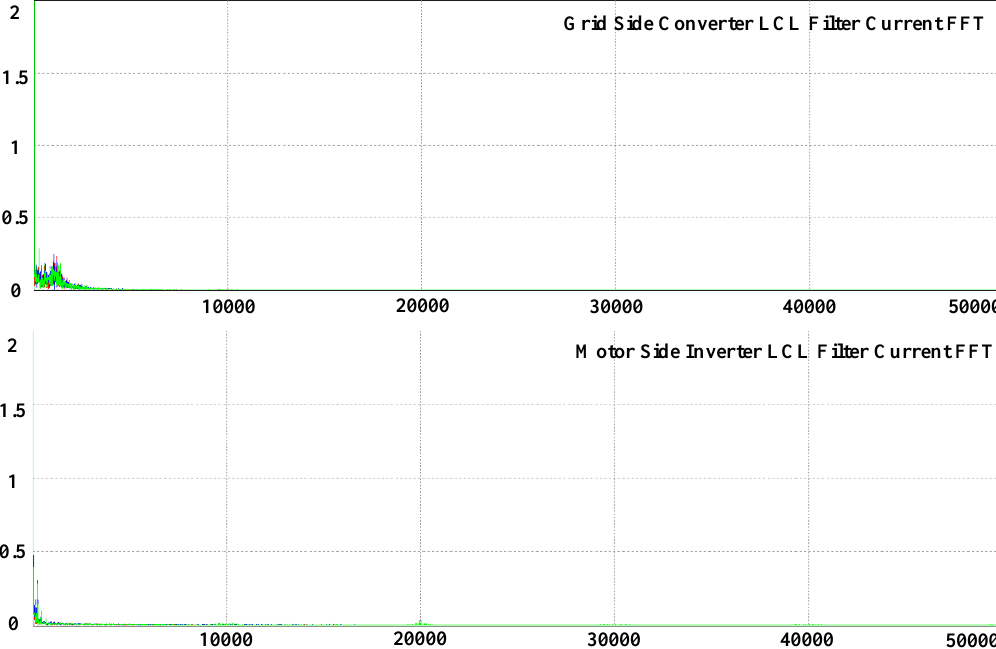
Figure 20. FFT analysis results of grid side LCL filter current and motor side current using the proposed ZDPWM method.